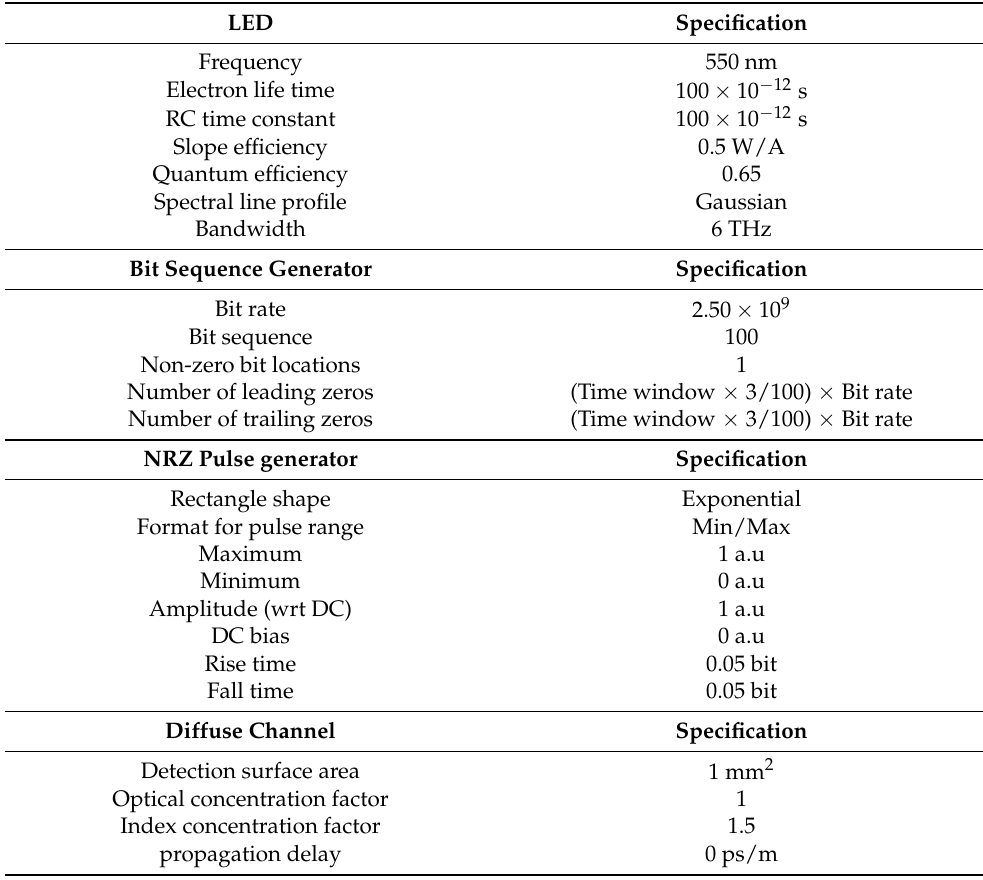
Figure 2. LOS propagation model simulation environment in Optisystem. Table 1. Components specification used in the Optisystem simulation